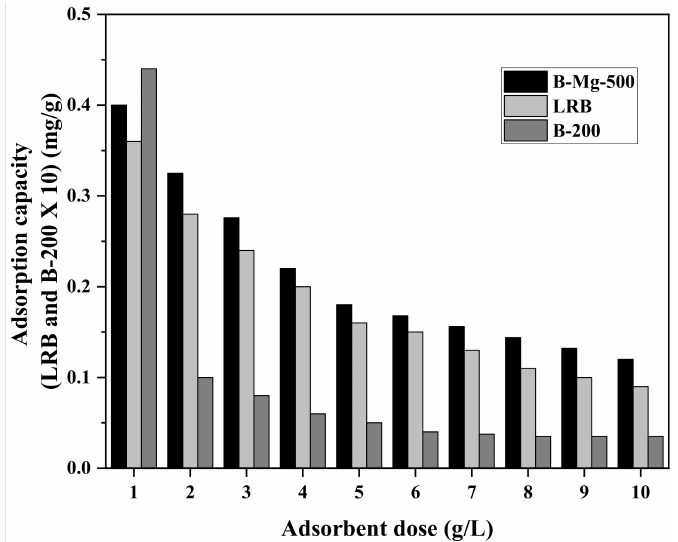
Figure 6. Effect of adsorbent dose on the adsorption capacity of some bauxite adsorbents. Data acquired from references